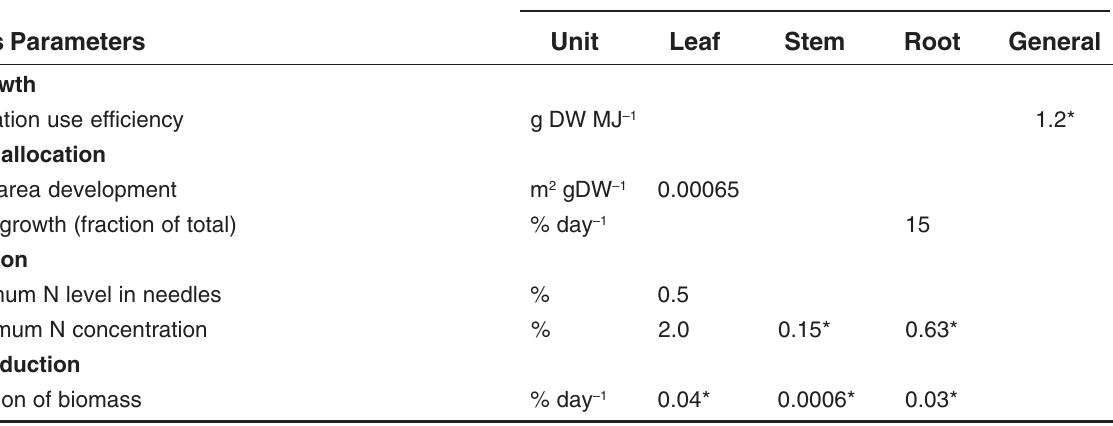
Main Parameter Settings in the Application SOILN Model to the Klosterhede Control Plot Ecosystem/Model